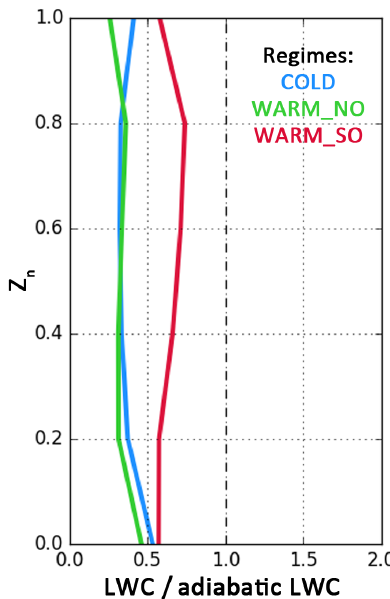
Figure 7. Vertical profiles of the ratio of measured LWC over theo- retical adiabatic LWC for the three